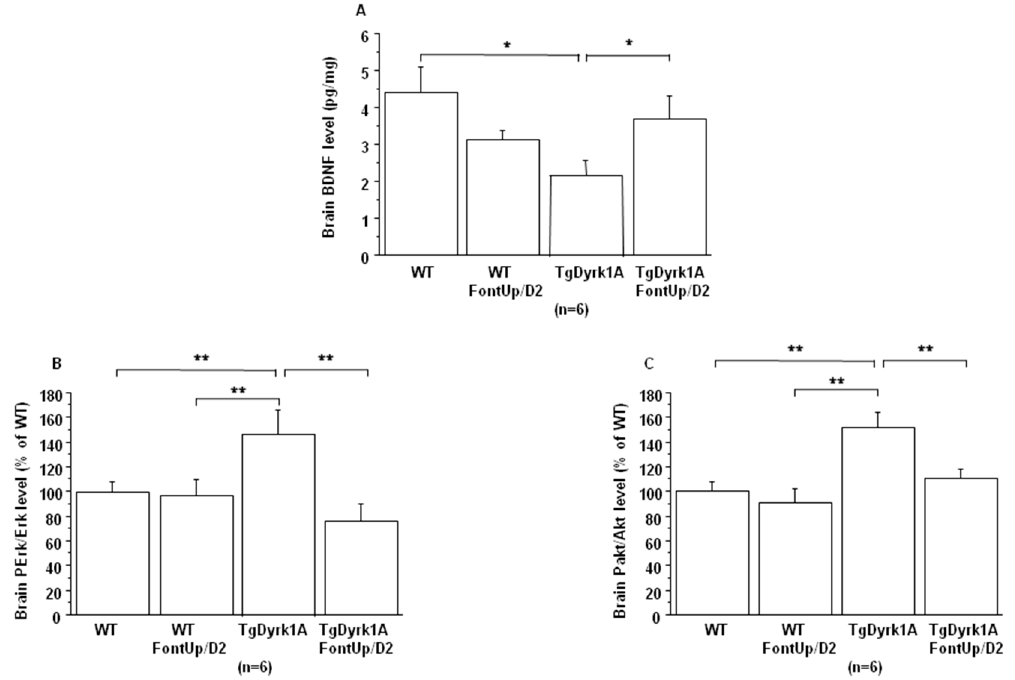
Figure 6. Comparison of brain BDNF level ( A ), and brain RTK activation ( B , C ) obtained from WT and mice overexpressing Dyrk1A (TgDyrk1A) after oral gavage of D2 FontUp ® during two days (FontUp / D2). BDNF levels were measured by ELISA, and Erk ( A ) and Akt ( B ) activation was analyzed by slot blot using antibodies specific to Perk or PAkt. After stripping, the membranes were rehybridized with anti Erk or anti Akt antibody for the control. Relative protein expression was determined by normalization of the density of images from PErk or PAkt with that of Erk or Akt of the same blot, and data were normalized to the mean of WT mice fed without FontUp ® . The values are mean ± SEM of n (number of mice) mice. Statistical analysis was done as mentioned in data analysis. * p < 0.05; ** p < 0.005.